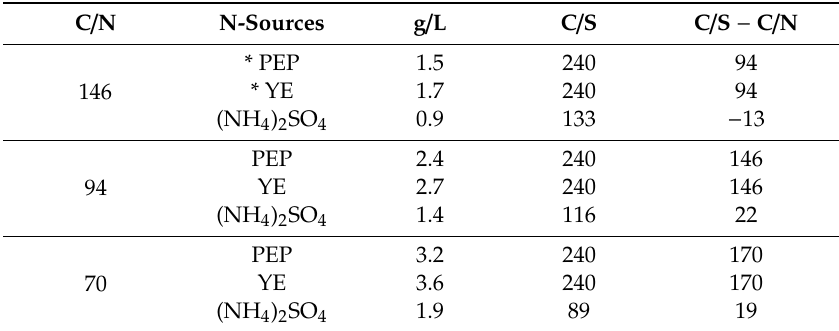
Table 1. Di ff erent nitrogen sources and its calculated carbon to nitrogen ratio (C / N) and carbon to sulfur ratio (C / S). C / N N-Sources g / L C / S C / S − C / N 1.5 146